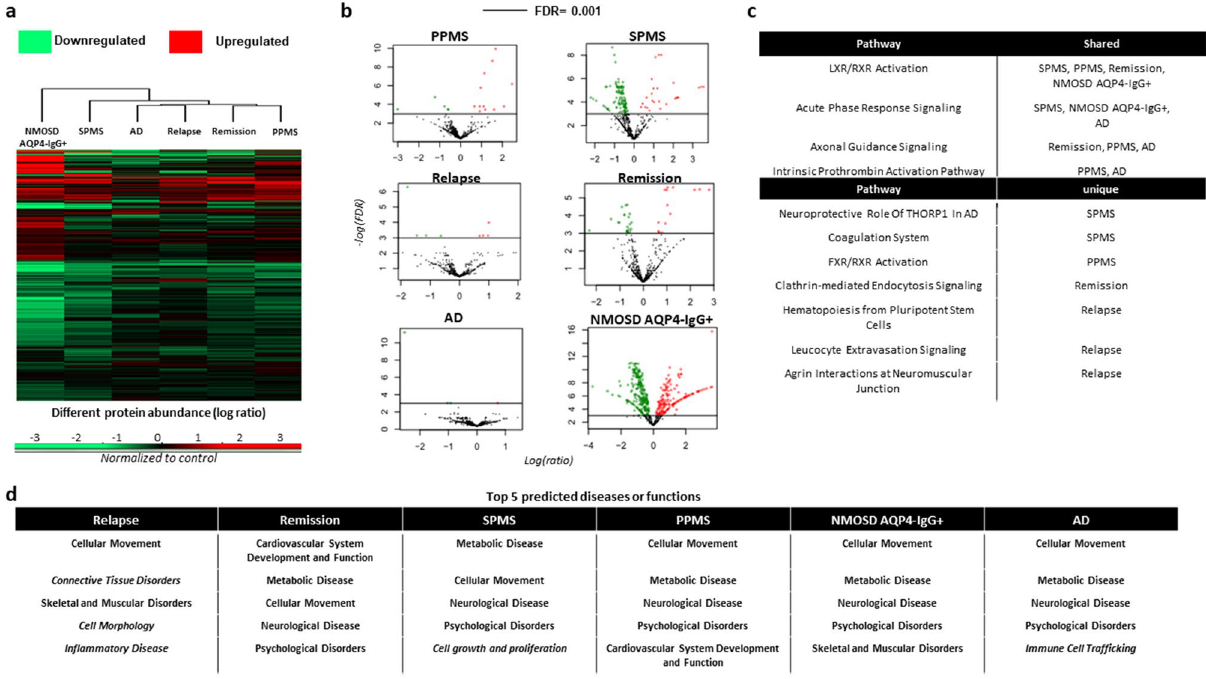
Figure 3. Functional analyses of the CSF proteome of disease groups normalized to healthy controls. ( a ) Heatmap clustering of PPMS, MS in relapse, MS in remission, SPMS, AD, and AQP4-IgG + NMOSD versus healthy control based on the different abundance of the protein levels. Red colour represents upregulation, while green represents downregulation in disease groups compared to healthy control. ( b ) Volcano plots of differentially expressed proteins in each disease group compared to healthy controls. Each point represents the average value of one protein in three replicate experiments. The dark horizontal line is set when the protein expression difference is significant with FDR < 0.001. ( c ) The top scoring canonical pathways for the different disease groups using Ingenuity Pathway Analysis (IPA) and z-score algorithms. ( d ) The top 5 predicted biological functions for each of the disease group compared to healthy control. Italic indicates a unique function for a disease group. CSF cerebrospinal fluid, PP/SPMS primary/secondary progressive multiple sclerosis, AD Alzheimer disease, AQP4‑IgG + NMOSD neuromyelitis optica spectrum disorder serum positive for aquaporin-4 antibody, FDR False discovery